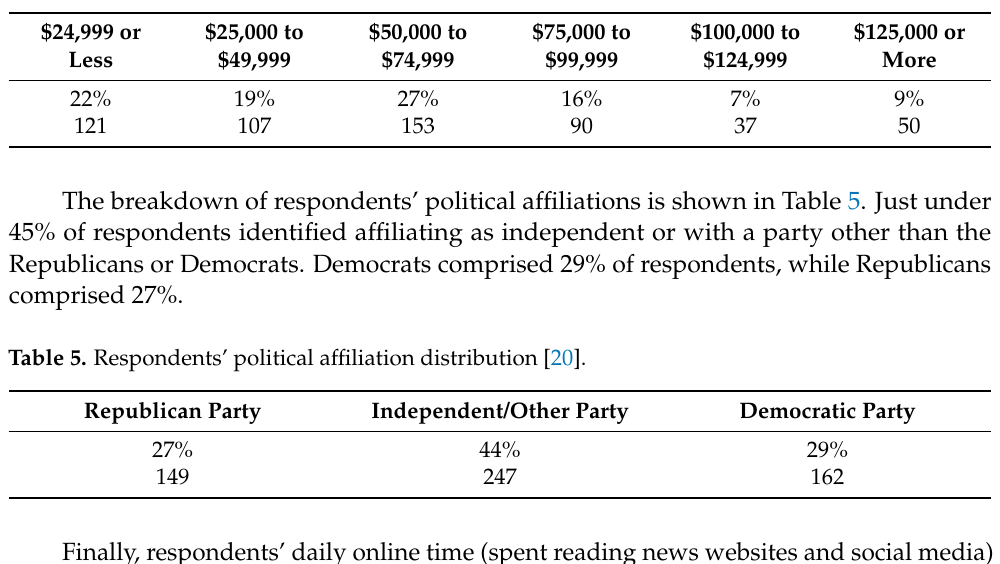
Table 4. Respondents’ income level distribution [20].